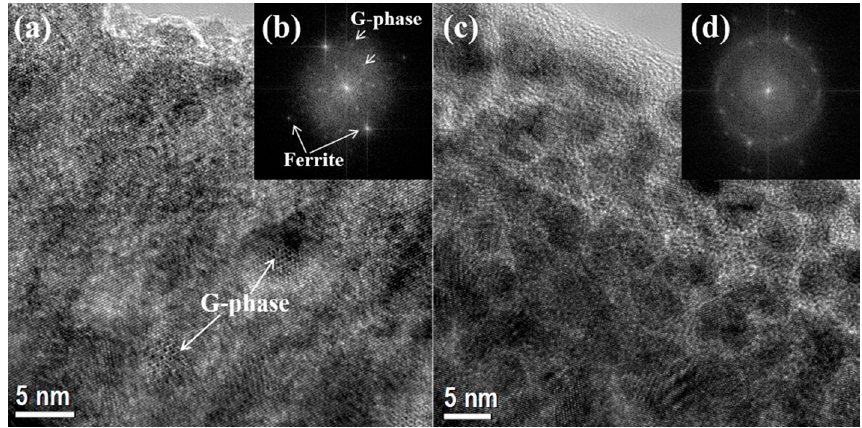
Figure 6. ( a ) HRTEM images of ferrite in the undeformed and ( c ) deformed samples of the steels thermally aged at 400 °C for 20,000 h. ( b ) and ( d ) are the corresponding FFT patterns of ( a ) and ( c ), respectively.